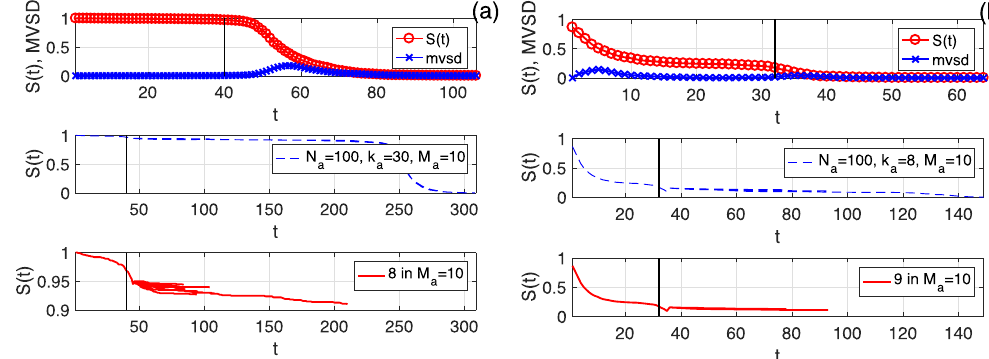
Figure 2. Examples of the system recovery after the early warning indicator. ( a ) One example of system recovery for ER networks with N = 1000 and 〈 k 〉 = 20. The uniformly random selection rule is used. M a = 10, k s = 11, q = 0.09, f = 0.1, N a = 100, and k a = 30. The threshold for determining a total collapse is d = 0.5. The upper panel shows the variation of S ( t ) (red line with circles) as well as the corresponding moving SD series (blue line with crosses). The black vertical line indicates the location of T pred . The middle panel shows all the 10 new time series (blue dashed lines) of S ( t ) after the node addition with T delay = 6. The lower panel shows the 8 trials of node addition (red lines) without total collapses among the M a = 10 trials in total. The threshold for determining a total collapse is d = 0.5. ( b ) Similar to (a) but for SF networks with γ = 1.8, k s = 5, q = 0.39, f = 0.2, N a = 100, k a = 8 and T delay = 5. For this example, there are 9 trials of node addition without total collapses within the 10 trials. The threshold for determining a total collapse is d =